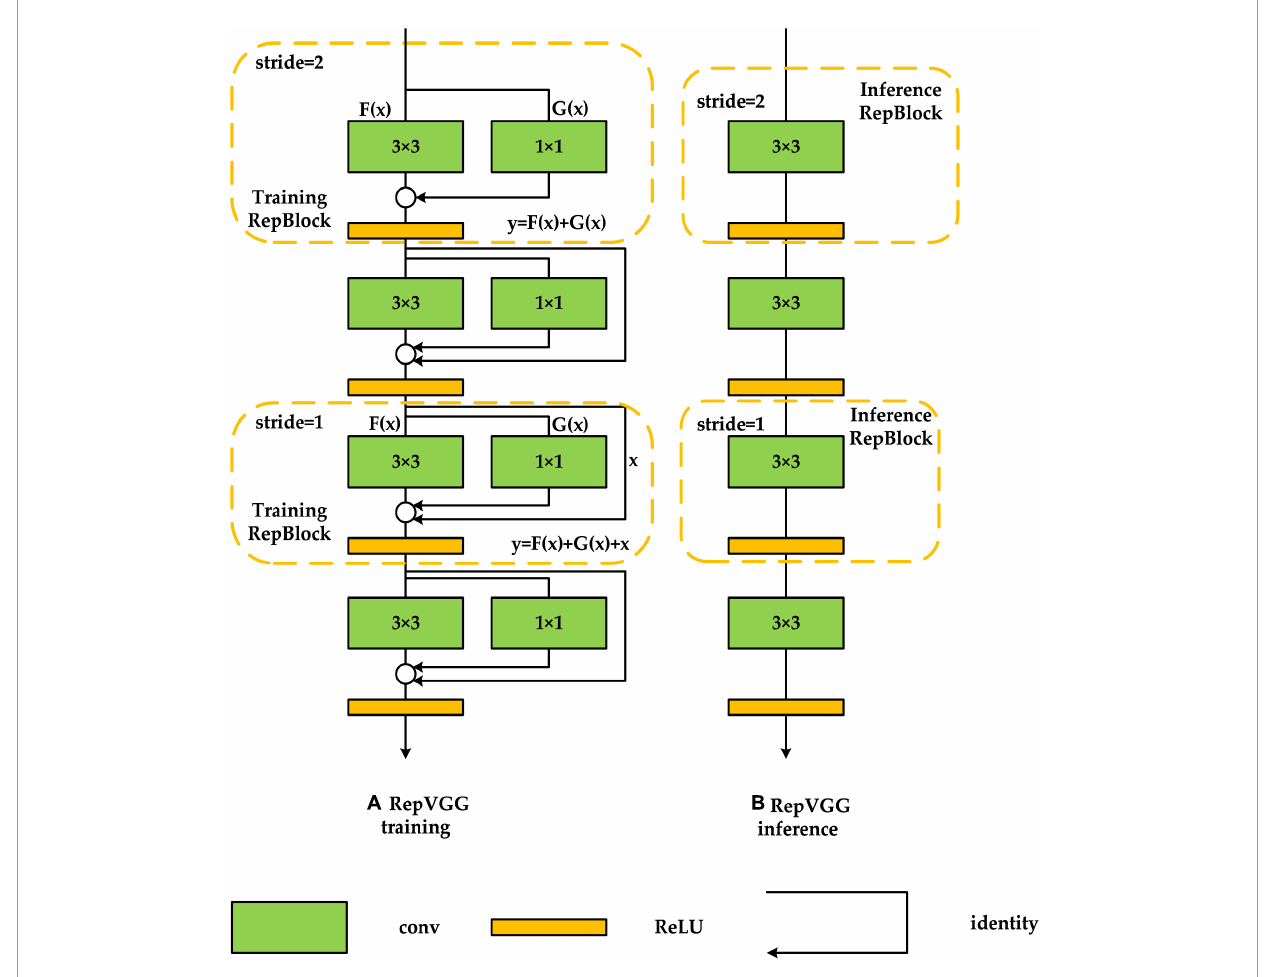
FIGURE4 RepVGG network structure. (A,B) Are the network structures of RepVGG in the training and inference process,